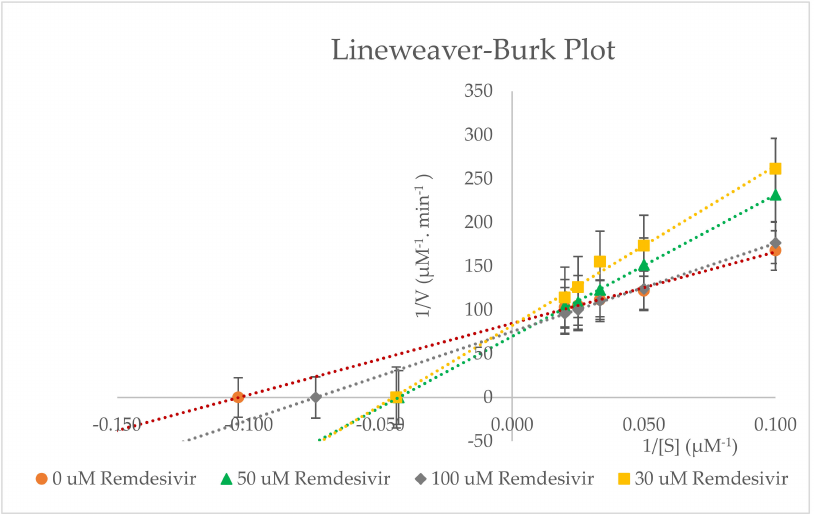
Figure 7. Lineweaver − Burk plot for the inhibition of CYP3A2 − mediated dexamethasone metabolism by various concentrations of remdesivir (0 − 100 µ M) in rat liver microsomes. Values are expressed as the average of triplicate measurements.